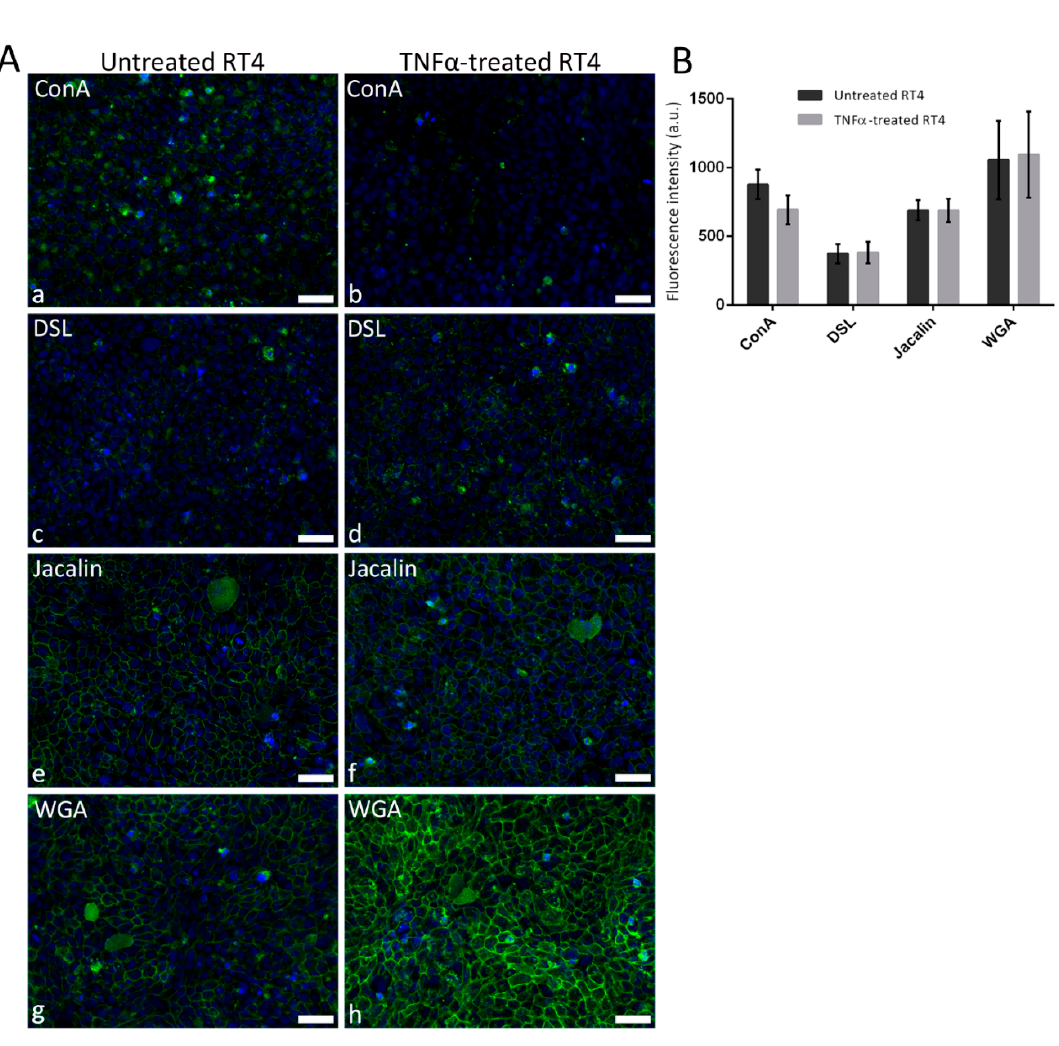
Figure 4. Lectin binding to control and TNF α -treated human urothelial RT4 cell line. ( A ) Representative micrographs of lectin fluorescence (green) in untreated controls ( a , c , e , g ) and TNF α -treated cells ( b , d , f , h ). Note that ConA and DSL label the cytoplasm ( a – d ), whereas Jacalin and WGA show a higher affinity for the plasma membrane. ( B ) Absolute values of fluorescence intensities in the RT4 cell line. Means ± SD of four independent experiments are shown. Nuclei are stained with DAPI (blue fluorescence). Scale bars: 50 µ